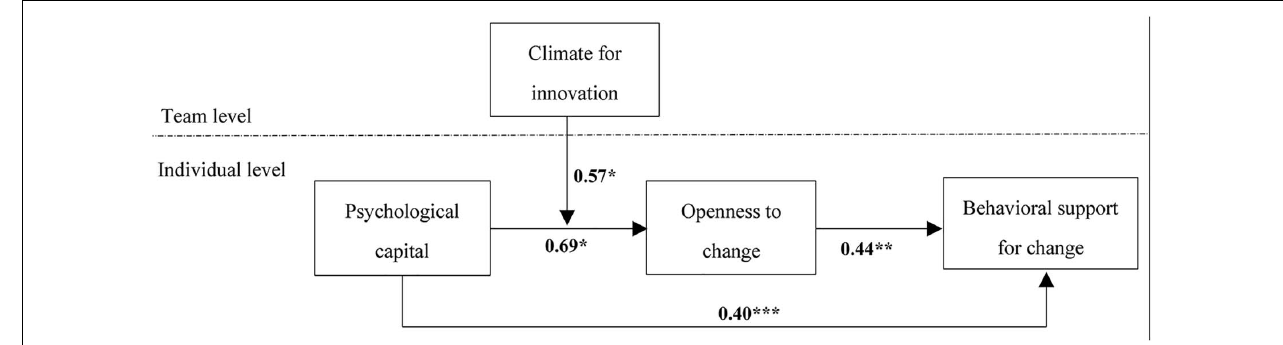
FIGURE 2 | Moderated mediation model path coefficients. For the sake of parsimony, we did not present the influences of control variables on behavioral support for change. Interested readers may contact the first author for estimates of these influences. *** p < 0.001;* p < 0.05.